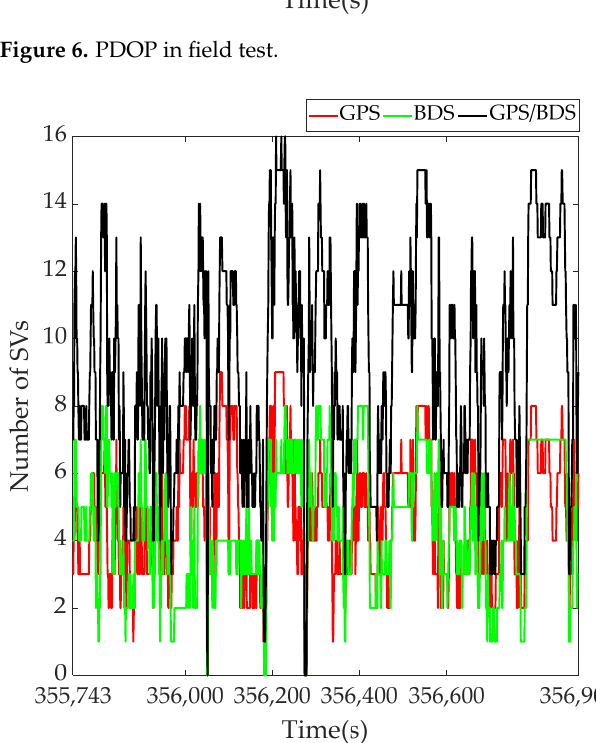
Figure 7. Visible satellite number in field test.